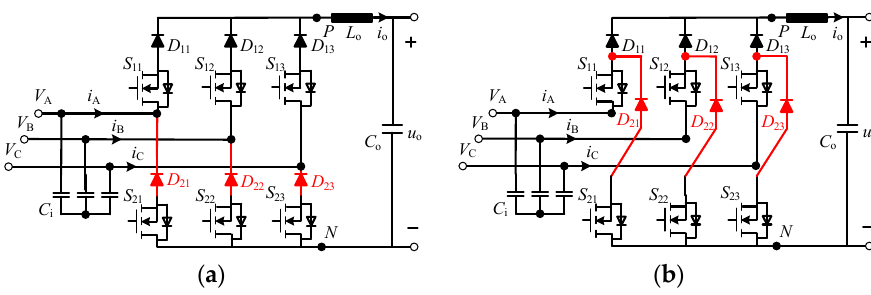
Figure 1. Topological structure. ( a ) Conventional current source rectifier (CSR). ( b ) Proposed CSR.